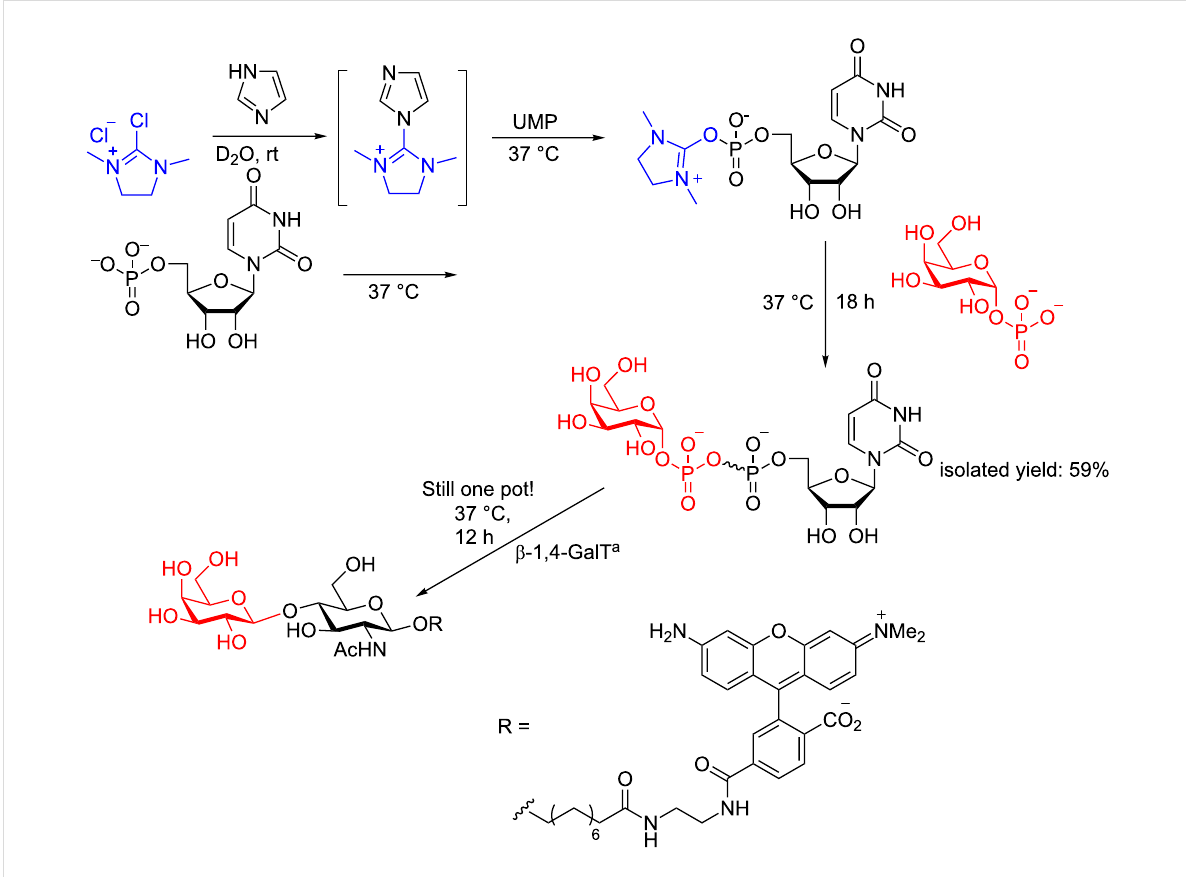
over 18 h at 37 °C, Gal-1-P can be coupled to form a diphos- phate (plus some dimerized UMP–UMP) that is fully isolatable. Adding to the power of this method is the ability for the in situ formed diphosphate to react enzymatically with for example the known GlcNAc analog shown in Scheme 29 using either an inverting (shown) or retaining glycosyl (not shown) transferase in the reaction mixture to form (for example) a LacNAc analog. The power of this methodology is clear: it is a straightforward method to complex oligosaccharides under mild and easy to handle